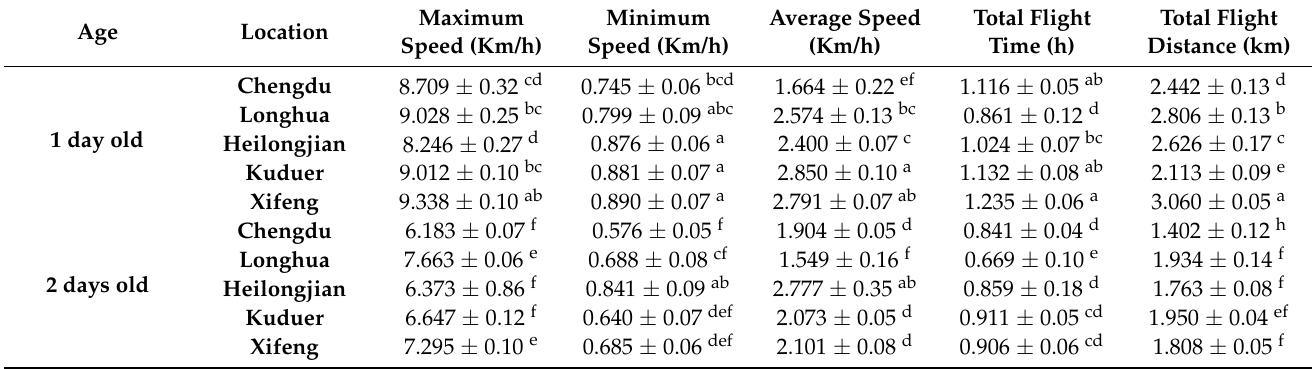
Table 4. The impact of age on different parameters concerning female Asian spongy moths’ ( L. dispar asiatica ) flight aptitude from five locations in China. Values are presented as Mean ±